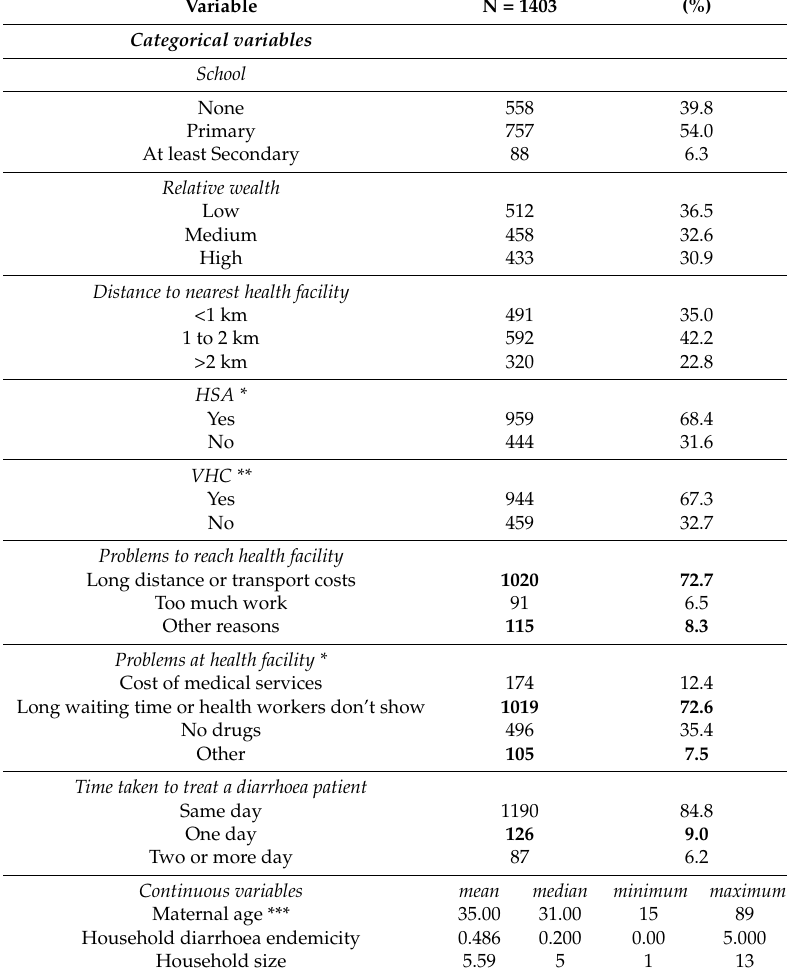
Table 2. Summary measures for predictor variables on diarrhoeal care seeking behaviour. Variable N = 1403